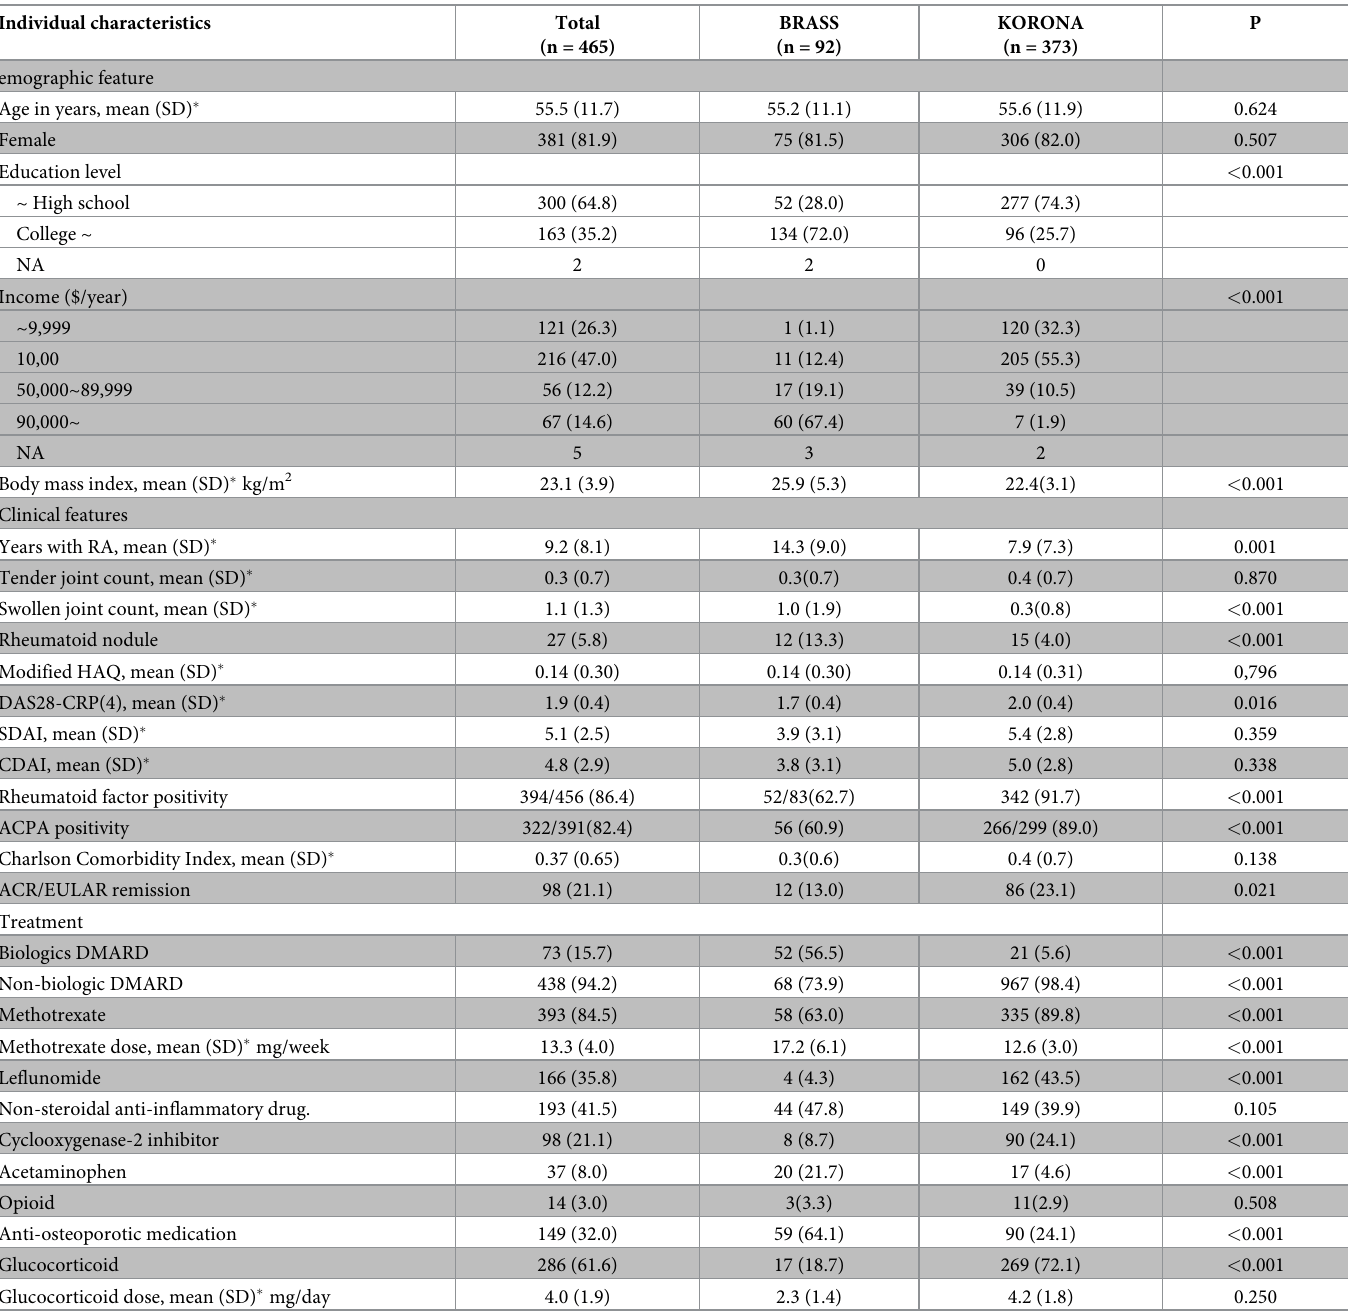
Table 1. Baseline characteristics of the study population (in